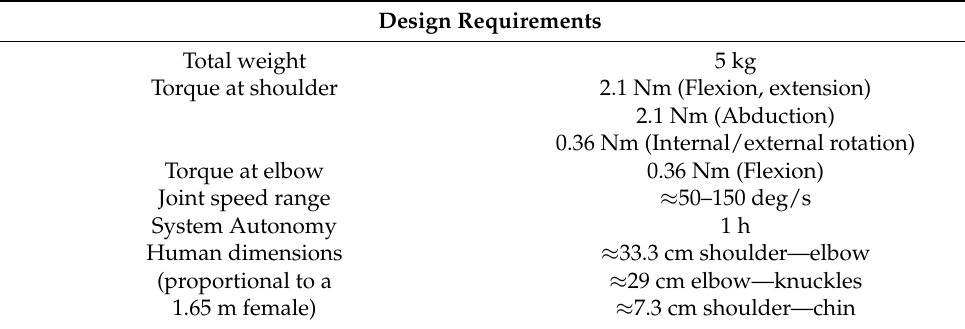
Table 1. Requirements for movable limbs